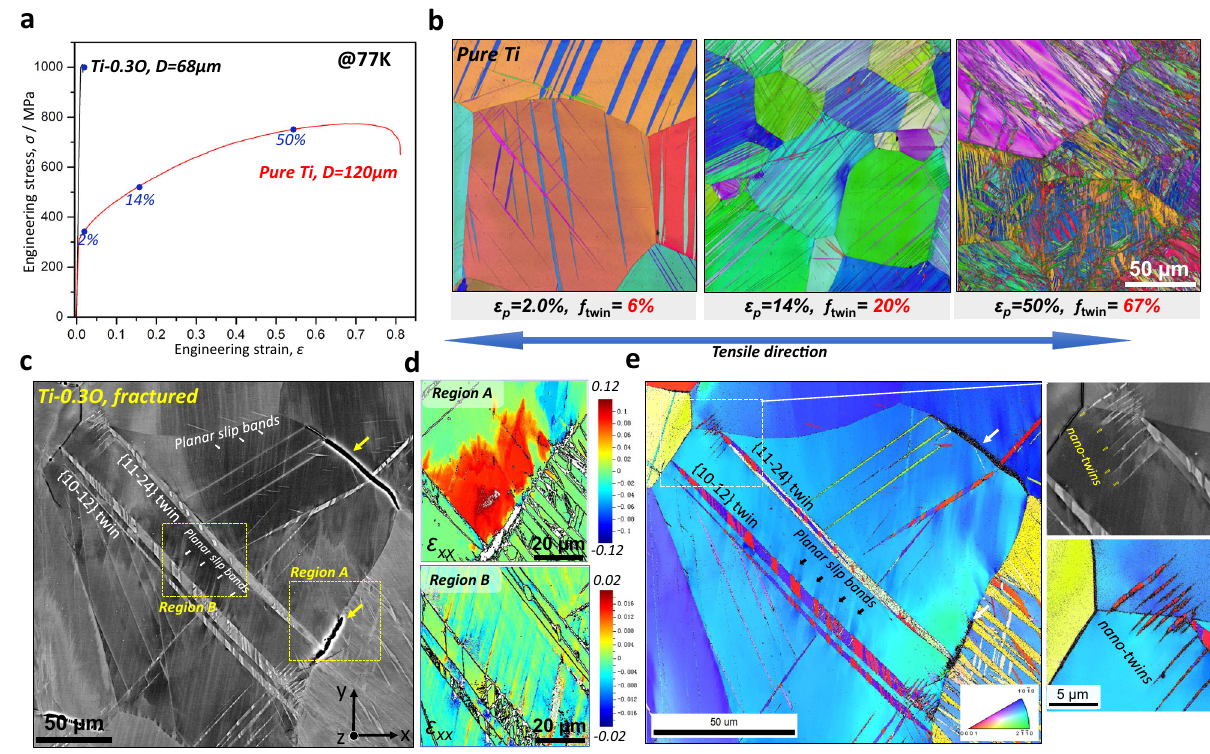
Fig. 3 | Mesoscopic deformation behavior of CG pure Ti and Ti-0.3O at 77K. a Engineeringstress-straincurvesofCGpureTiandTi-0.3Oat77K. b EBSDinverse pole fi gure (IPF) maps of CG pure Ti at interrupted plastic strains of 2.0%, 14% and 50%. The fraction of deformation twins is given for each strain. c Back-scattered electron (BSE) image of CG Ti-0.3O after tensile fracture (1.5%), in which GB cracks